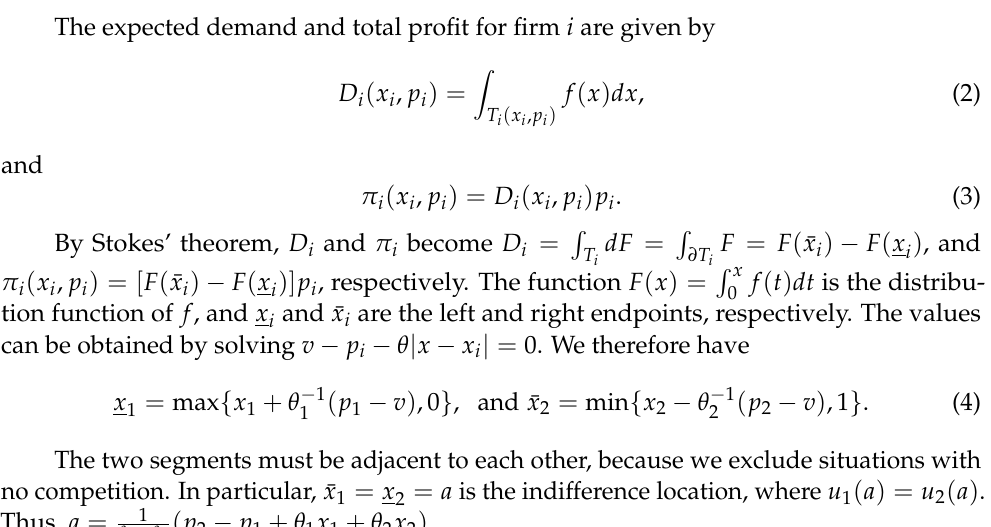
Figure 2. Classical Hotelling model suffers from the problem of discontinuity. Subfigure ( A ) shows that the triangle shape of transportation cost functions gives rise to a possibility of discontinuity from line ¯ AB to ¯ A (cid:48) B (cid:48) , which is caused by the sudden change in the disappeared intersection between two parallel lines. Subfigure ( B ) shows that no sudden change in the intersection will be encountered if the triangles overlap